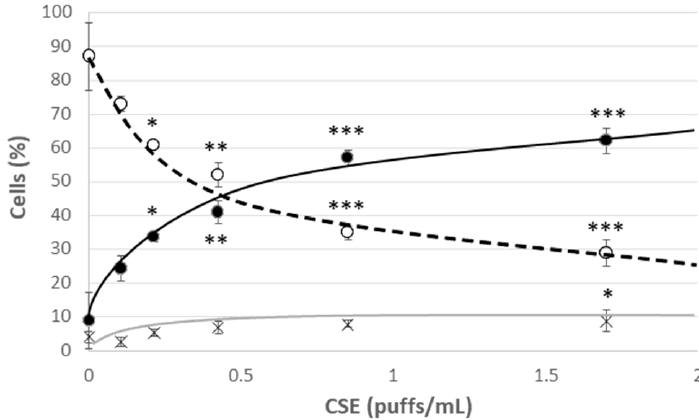
Figure 2. Cell viability after 24 h treatment of young HUVECs with increasing doses of CSE. O Live cells, ● Apoptotic cells, X Dead cells. Significance was calculated with respect to young untreated cells (0 puffs/mL CSE). * p ≤ 0.05, ** p ≤ 0.01, *** p ≤ 0.001. Parallel to the increase in mitochondrial ROS, a significant opening in mPTP was observed (Y: 26 ± 3%; Y + CSE: 39 ± 3%; p ≤ 0.001) (Figure 3C), suggesting that incubation of young